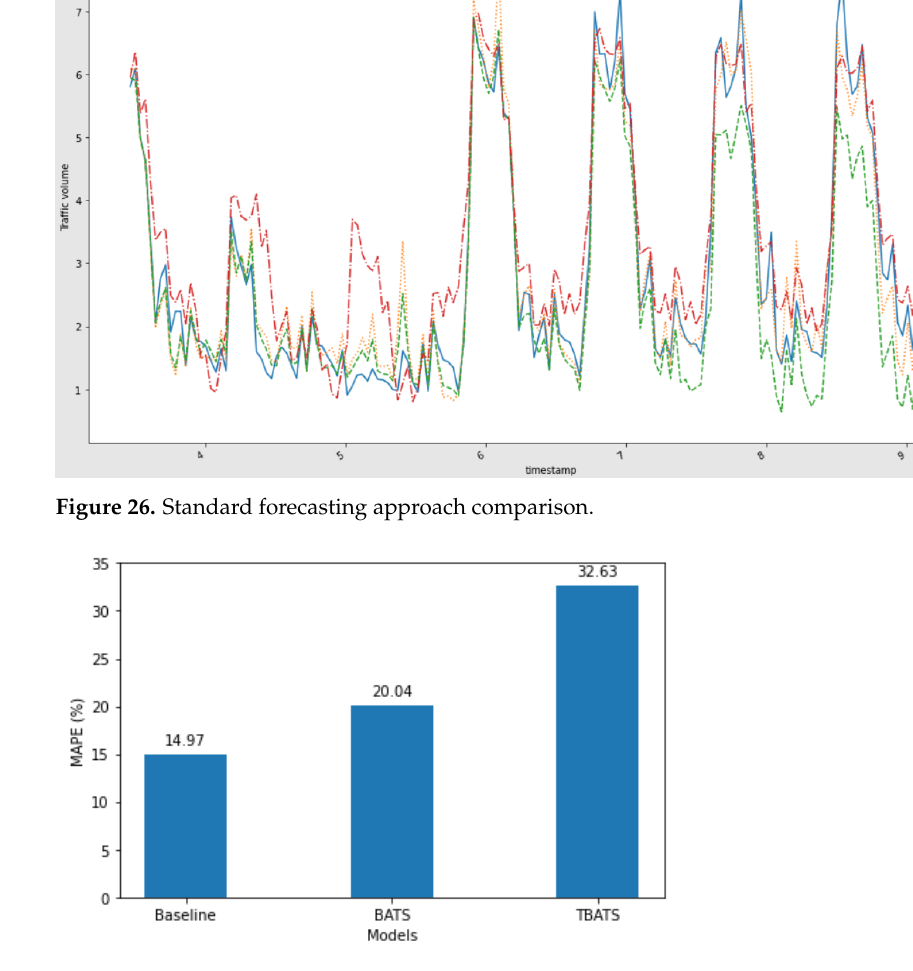
Figure 27. BATS and TBATS models